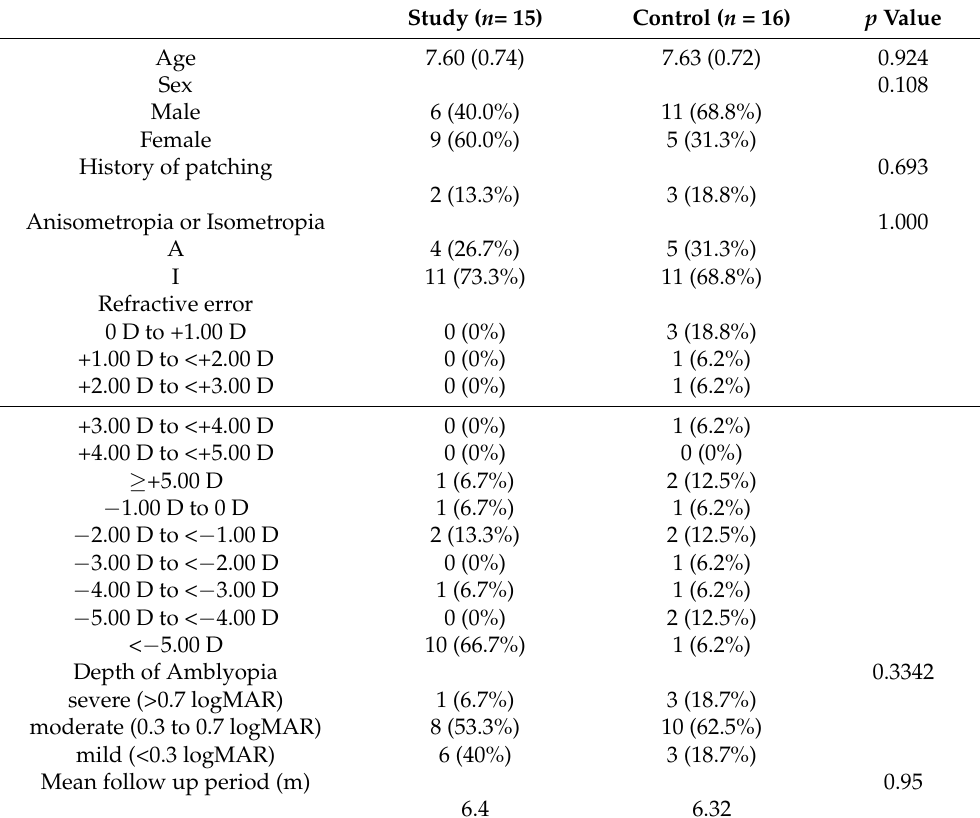
Table 1. Demographic data of case and control